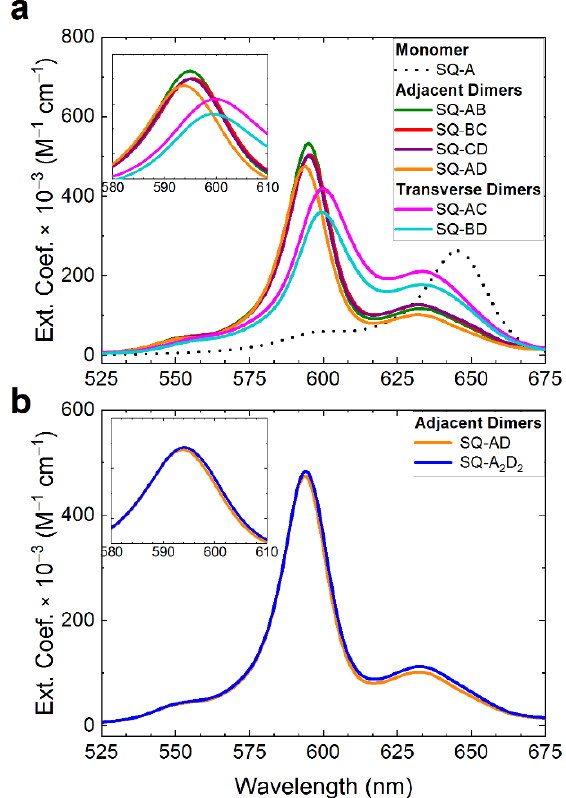
Figure 4. Acquired steady-state absorption spectra recorded in 1× TBE, 15 mM MgCl 2 at room tem- perature and converted to extinction of squaraine-DNA HJ constructs. The DNA-dye construct con- centration was 1.5 μM. ( a ) Adjacent and transverse dimers (solid lines) and a monomer (dash line). concentration was 1.5 µ M. ( a ) Adjacent and transverse dimers (solid lines) and a monomer (dash ( b ) Transverse SQ-AD and SQ-A 2 D 2 dimers. line). ( b ) Transverse SQ-AD and SQ-A 2 D 2